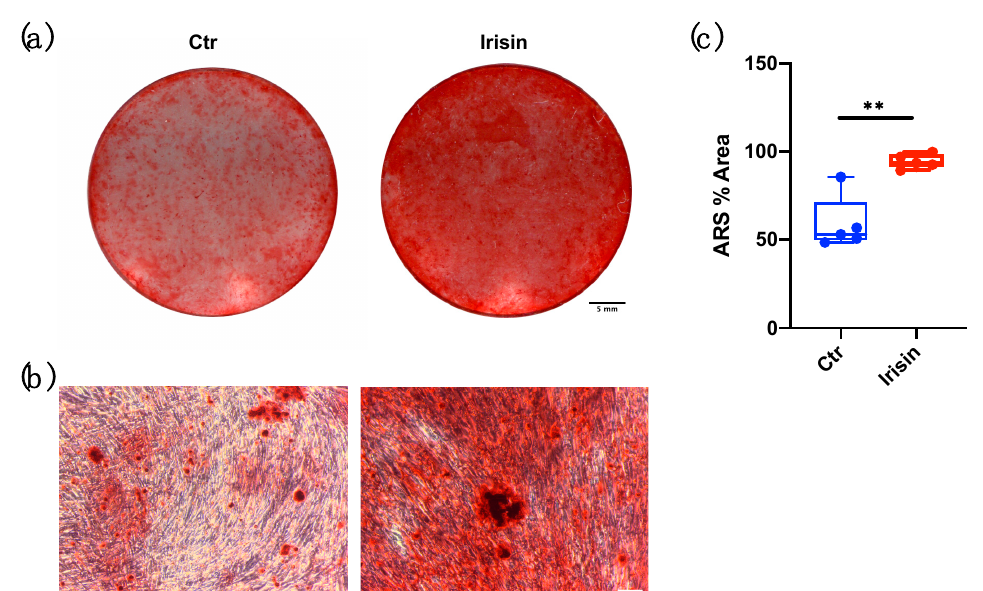
Figure 5. Mineralized nodules formation following irisin stimulation and alizarin red staining (ARS) quantification. ( a ) Mineral matrix deposition, assessed by ARS (red staining), in DBSCs cultured in osteogenic conditions and treated with irisin or not (Ctr) for 21 days. The figure shows the wells of a representative experiment. Scale bar: 5 mm. ( b ) Phase contrast pictures displaying the formation of calcified nodules. Scale bar: 100 µ m. ( c ) The graph shows the quantification of ARS % area presented as box-and-whisker plots with median and interquartile ranges, from max to min, and is representative for five independent experiments performed in quadruplicates. ** p < 0.01. Statistics: unpaired Student’s t -test.